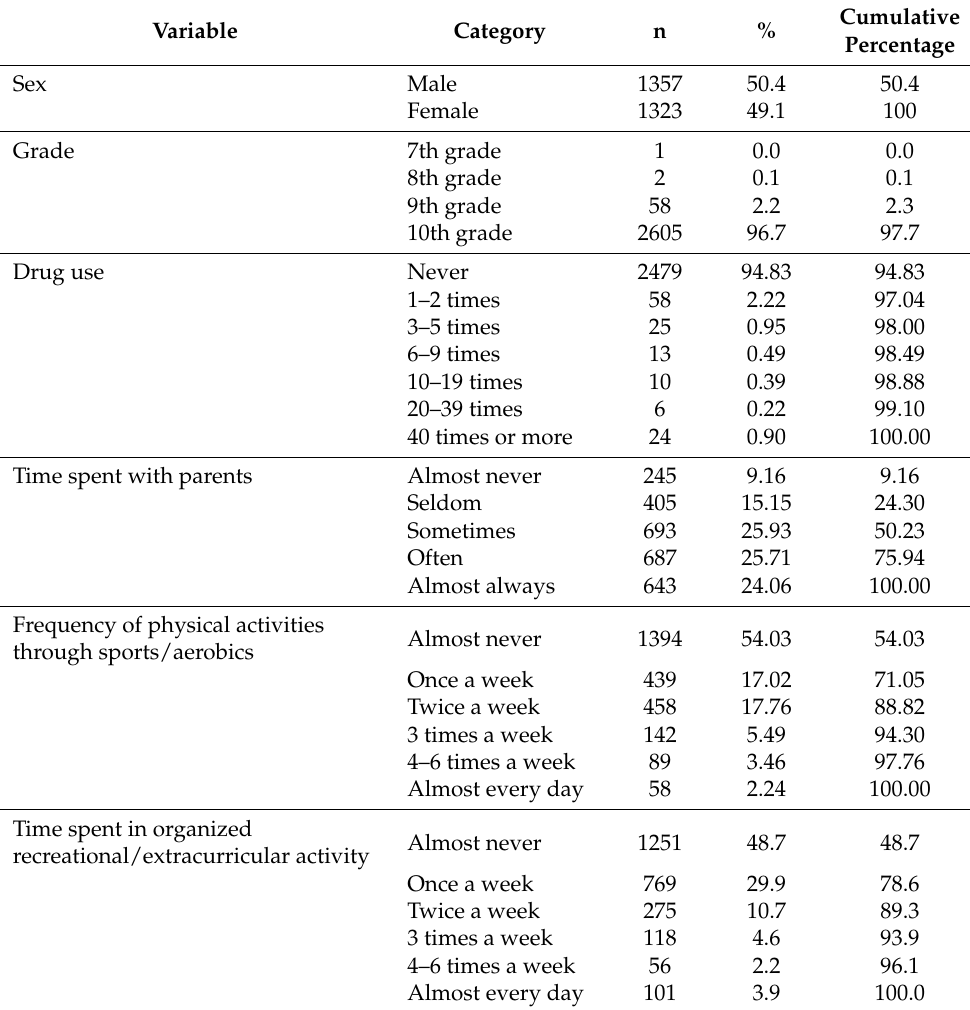
Table 1. Descriptive statistics for the categorical variables in the database: variable name, categories, frequencies, percentages, and cumulative